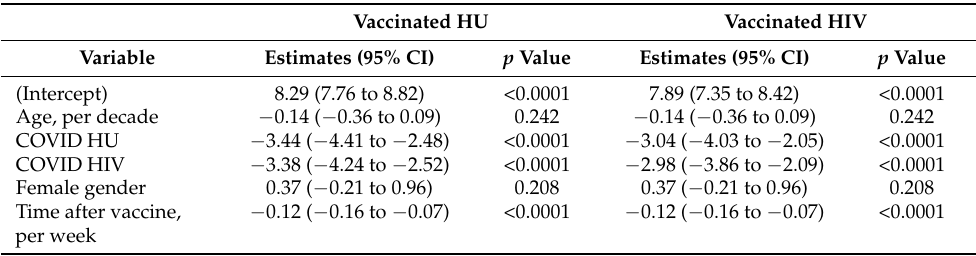
Table 3. Multivariate linear regression analysis of the serum spike-specific IgG levels of SARS-CoV-2 vaccinated subjects compared to COVID-19 convalescent subjects.